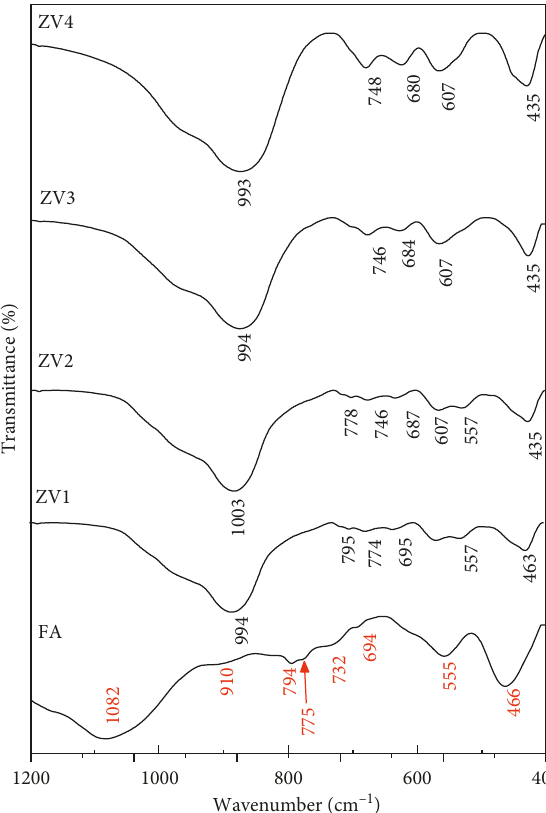
Figure 3: FTIR spectra of FA and synthesis products.